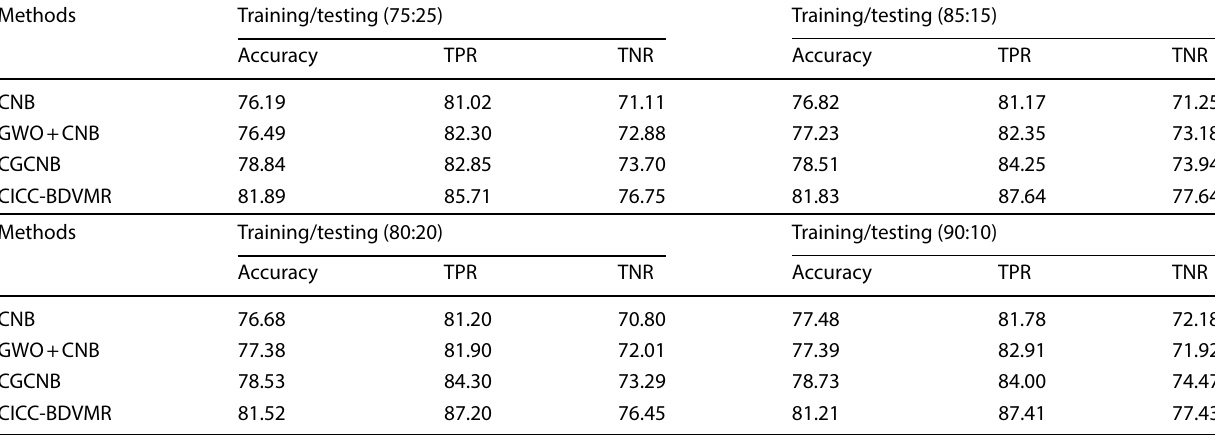
Table 4 Average analysis of CICC-BDVMR technique under distinct sizes of training/testing data in skin data